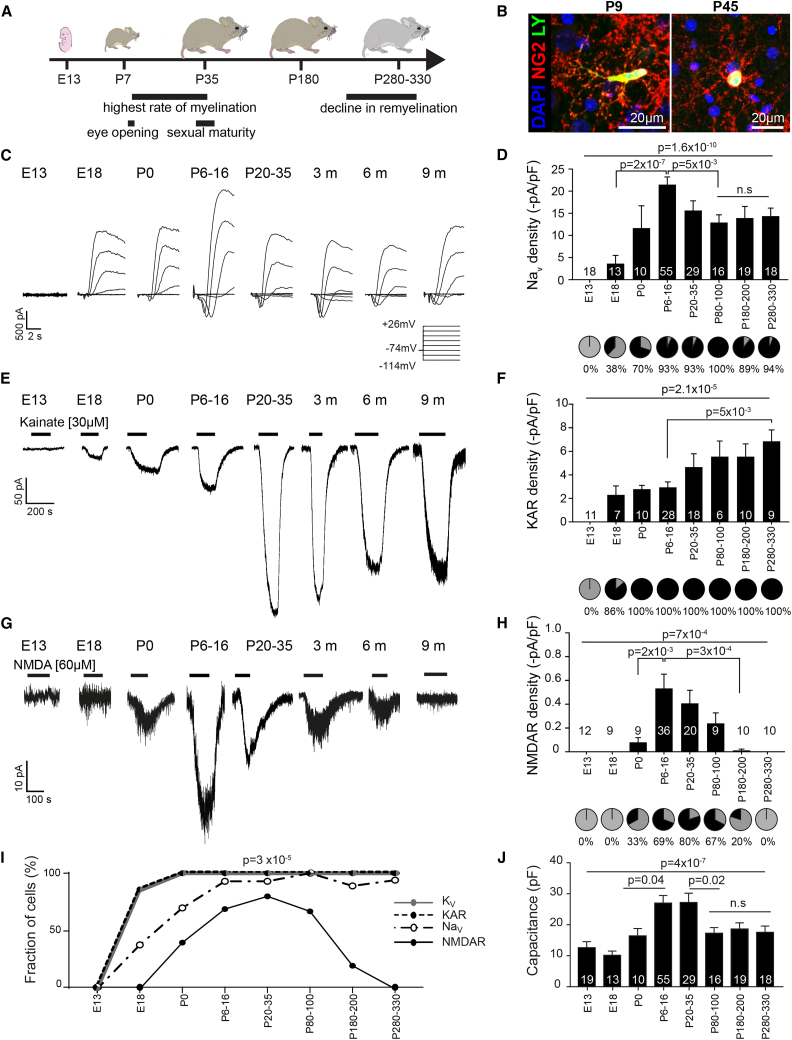
OPCs Acquire Functional Ion Channels at Different Developmental Time Points(A) Schematic diagram of the mouse developmental timeline, indicating developmental and myelination-related milestones over the period studied.(B) Cells were selected by their EYFP expression (NG2-EYFP knockin mice). During whole-cell patch-clamp recording, OPCs were dye-filled with Lucifer Yellow (LY, green) and post hoc-labeled for NG2 (red). Scale bar, 20 μm.(C) Leak-subtracted traces of voltage-gated sodium currents (NaV) in response to 20-mV steps from a holding potential of −74 mV (inset, voltage pulses from −114 to +26 mV) in OPCs from E13 to 9-month-old-mice.(D) NaV densities were significantly different between age groups (p = 1.6 × 10−10). NaV densities peak at P6–P16 (at the time when myelination is at its highest rate; A). The proportion (pie charts) of OPCs with (black) or without (gray) detectable NaV currents differed (p < 1 × 10−15, χ2) with age.(E) Kainate (30 μM)-evoked currents in OPCs from E13 to 9-month-old-mice.(F) The density of AMPA/kainate receptors (KARs) increased steadily with age (p = 2.1 × 10−5, ANOVA), and the proportion (pie charts) of OPCs with (black) detectable KA-evoked currents increased (p < 1 × 10−15, χ2) until after birth, when all OPCs had detectable KA-evoked currents.(G) NMDA (60 μM)-evoked currents in OPCs from E13 to 9-month-old-mice.(H) The density of NMDA receptors (NMDARs) in OPCs changed significantly with age (p = 7 × 10−4, ANOVA). Similarly, the proportion (pie charts) of OPCs with (black) detectable NMDA (60 μM)-evoked currents changed with age (p < 1 × 10−15, χ2). Both current density and OPCs with detectable currents peaked during P6–P35, at the time when myelination is at its highest rate, and declined until becoming undetectable (gray).(I) The fraction of OPCs with detectable voltage-gated potassium (KV) or NaV channels and with detectable KAR-evoked and NMDA receptor (NMDAR)-evoked currents across the lifespan. KV and KA-evoked currents are first detected in OPCs, followed by NaV; all three remain present in the majority of postnatal OPCs throughout life. In contrast, NMDA-evoked currents are detected last, and only during the period of highest myelination are NMDARs detected in the majority of OPCs. At later ages, NMDARs become undetectable. KV, p < 1 × 10−15; NaV, p < 1 × 10−15, χ2; KAR, p < 1 × 10−15, χ2; NMDA, p < 1 × 10−15, χ2. The onset of detection between receptors differs (p = 4.3 × 10−6), and the fraction of OPCs with detectable currents differs across age (p = 2.7 × 10−5).(J) OPC capacitance peaks with myelination rate and then declines back to perinatal levels.The numbers shown on graphs represent the number of whole-cell patched OPCs from 2–21 animals. Top p values are from ANOVA analyses, whereas bottom p values are from post hoc Holm-Bonferroni analyses. Data are shown ± SEM.